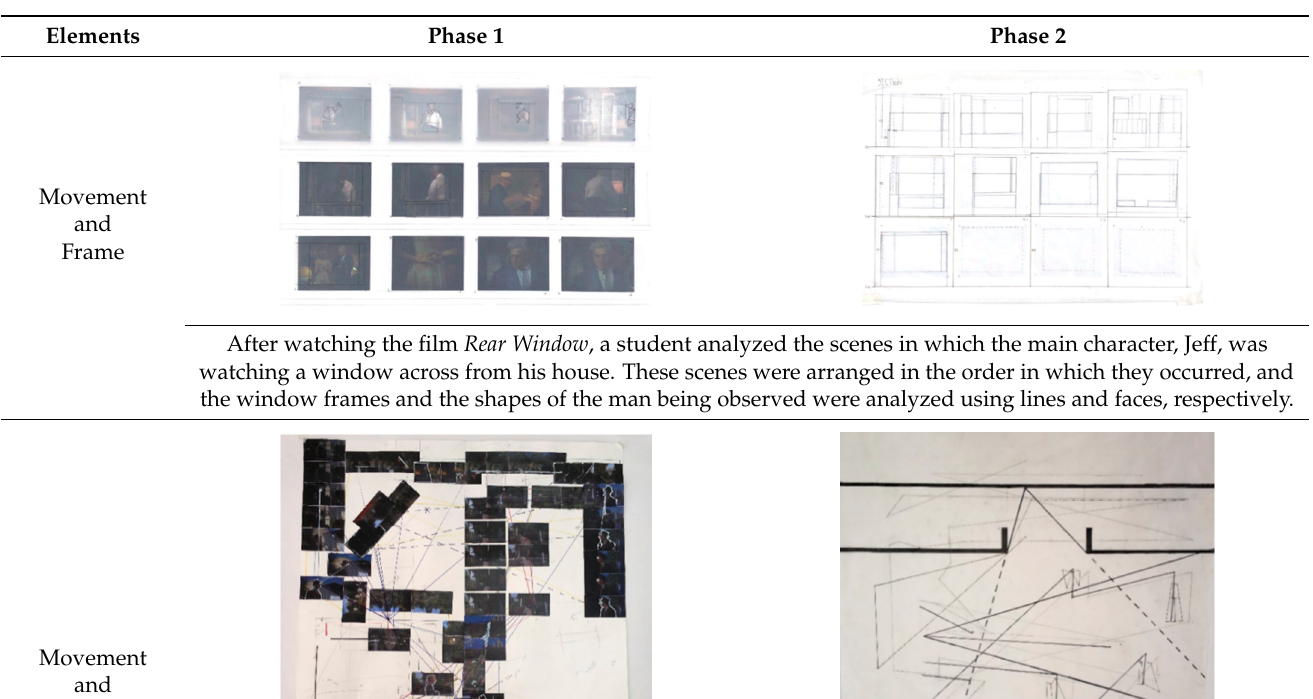
Table 5. Student representations of filmic elements.